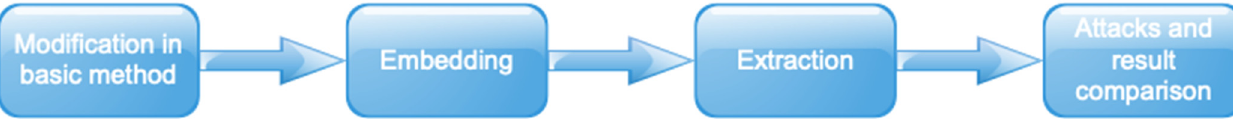
Figure 1. A basic model of a watermarking system.